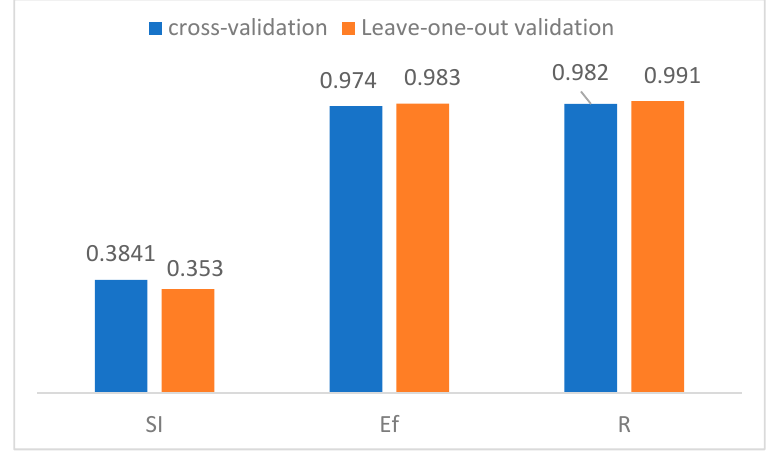
Figure 13. Comparison of the cross-validation and leave-one-out validation methods for the GRNN model.